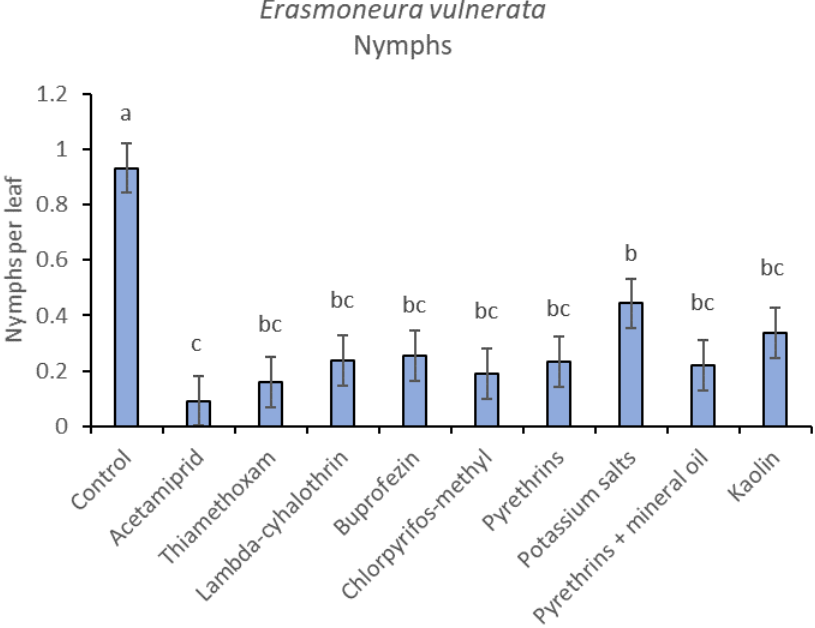
Figure 2. Least-square means ( ± std. err.) of Erasmoneura vulnerata nymphs observed on different treatments in the 2017 trial. Different letters indicate significant differences at t -test ( α = 0.05). When early (I-II instar) and older (III-V instar) nymphs were considered separately, differences among treatments emerged only for the former (F = 3.03; d.f. = 9, 38.6; p =